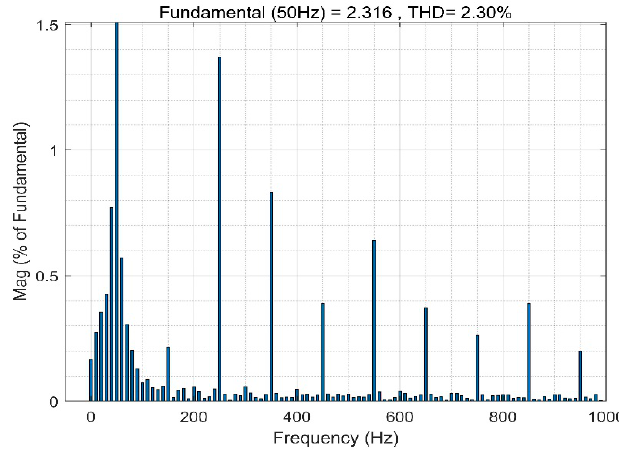
Figure 7. Harmonic spectrum of power supply current in steady state.